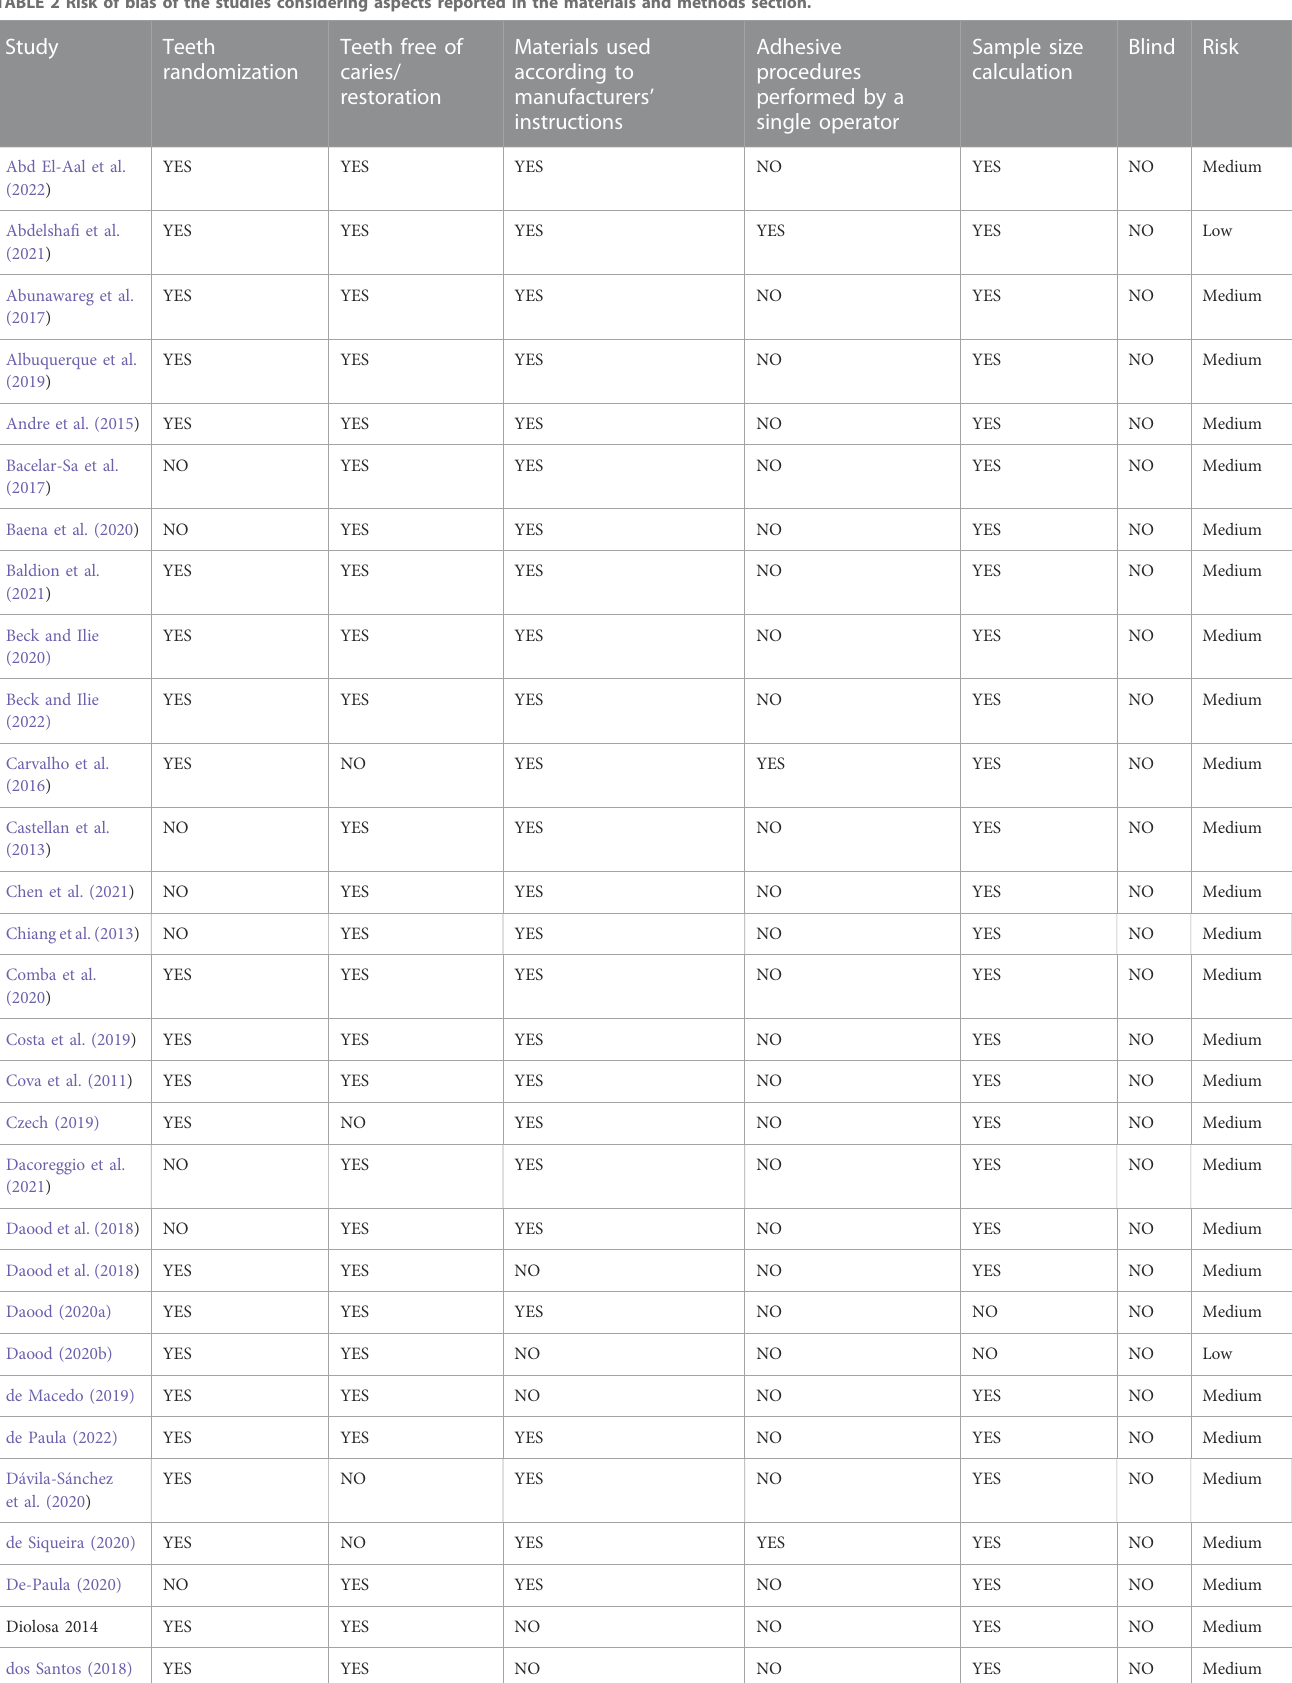
TABLE 2 Risk of bias of the studies considering aspects reported in the materials and methods section.